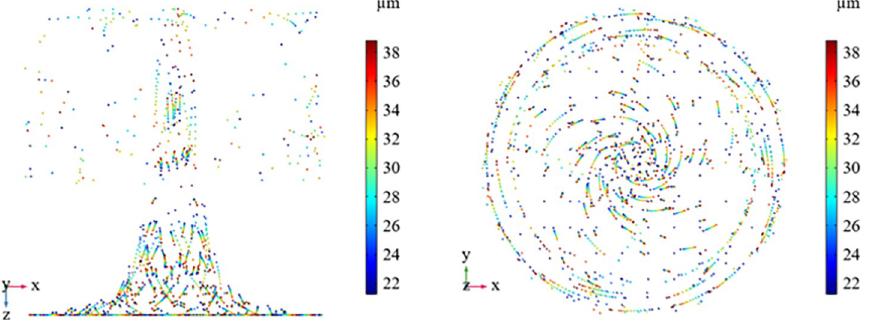
Fig 12. Spiral pneumatic spray fog drip particle